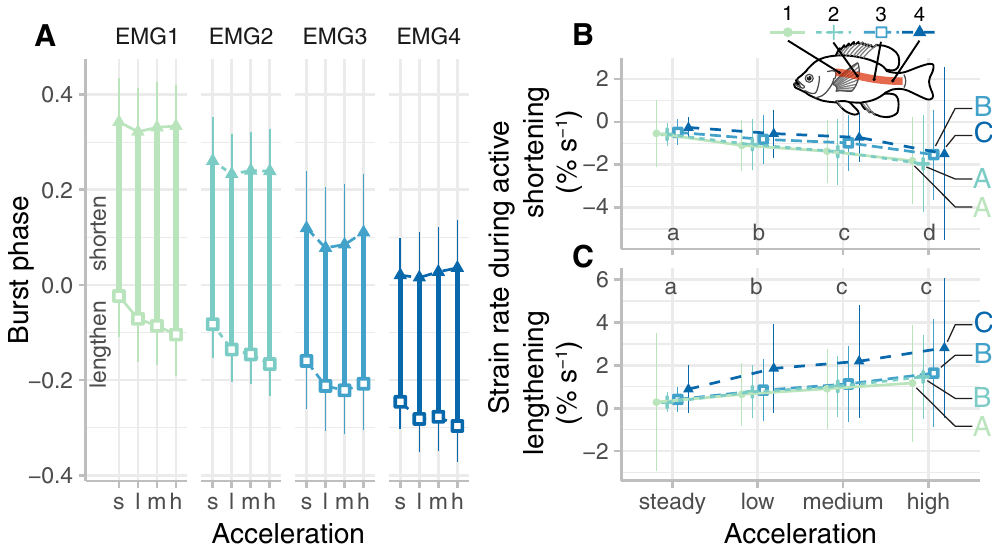
Figure 4. Bluegill sunfish ( N = 5) increased eccentric contractions during forward accelerations versus steady swimming. ( A ) Onset and offset of muscle activation relative to body curvature, showing when the red muscle was active during lengthening (phase = − 0.5-0) or shortening (phase = 0–0.5). See Table S4 for statistical results. ( B ) While the muscle was actively shortening, strain rate increased in magnitude (became more negative) with increasing acceleration but decreased along the body. ( C ) While the muscle was lengthening, strain rate increased with increasing acceleration and along the length of the body. Acceleration groups and EMG locations labeled with different lowercase or uppercase letters, respectively, are significantly different from one another (p < 0.01). See Table S3 for statistical